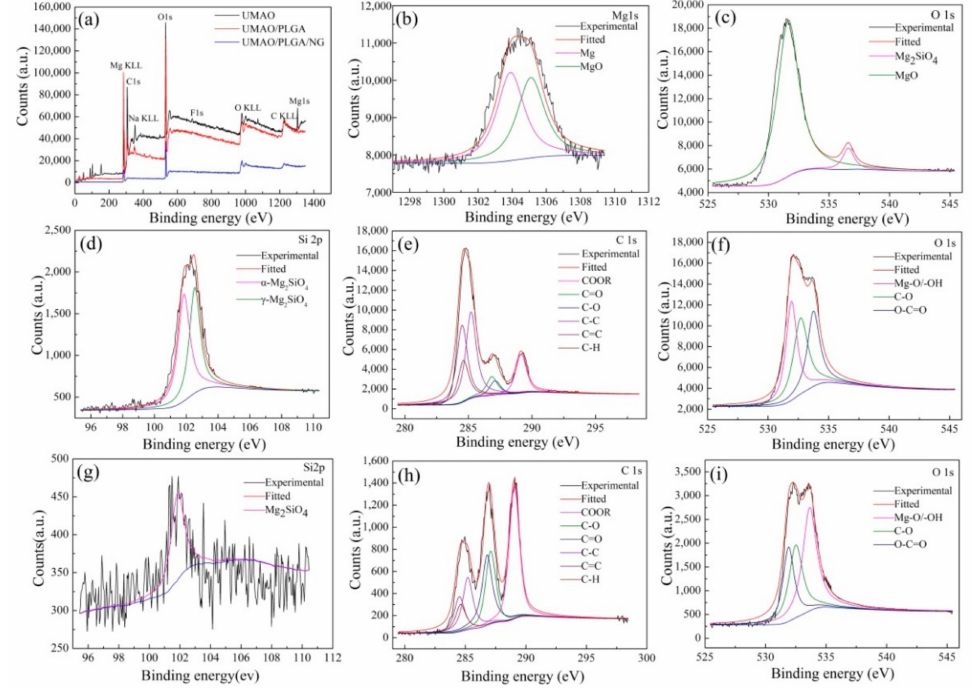
Figure 4. ( a ) XPS spectrum of the different coatings, ( b – d ) detailed XPS spectra of the Mg 1s, O 1s, and Si 2p for the UMAO coating, respectively, ( e – g ) detailed XPS spectra of the C 1s, O 1s, and Si 2p for the UMAO/PLGA coating, respectively; and ( h , i ) detailed XPS spectra of the C 1s and O 1s for the UMAO/PLGA/NG coating,